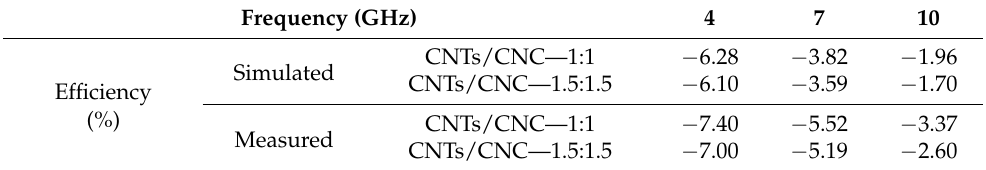
Table 7. PICA gain simulations and measurements at 4, 7, and 10 GHz for both ink